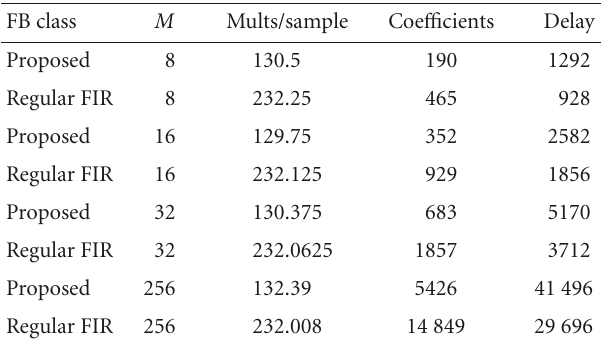
Table 1: Number of multiplications per sample, total delay, and number of optimization parameters using the proposed prototype filters or a regular FIR prototype filter, for di ff erent numbers of channels.